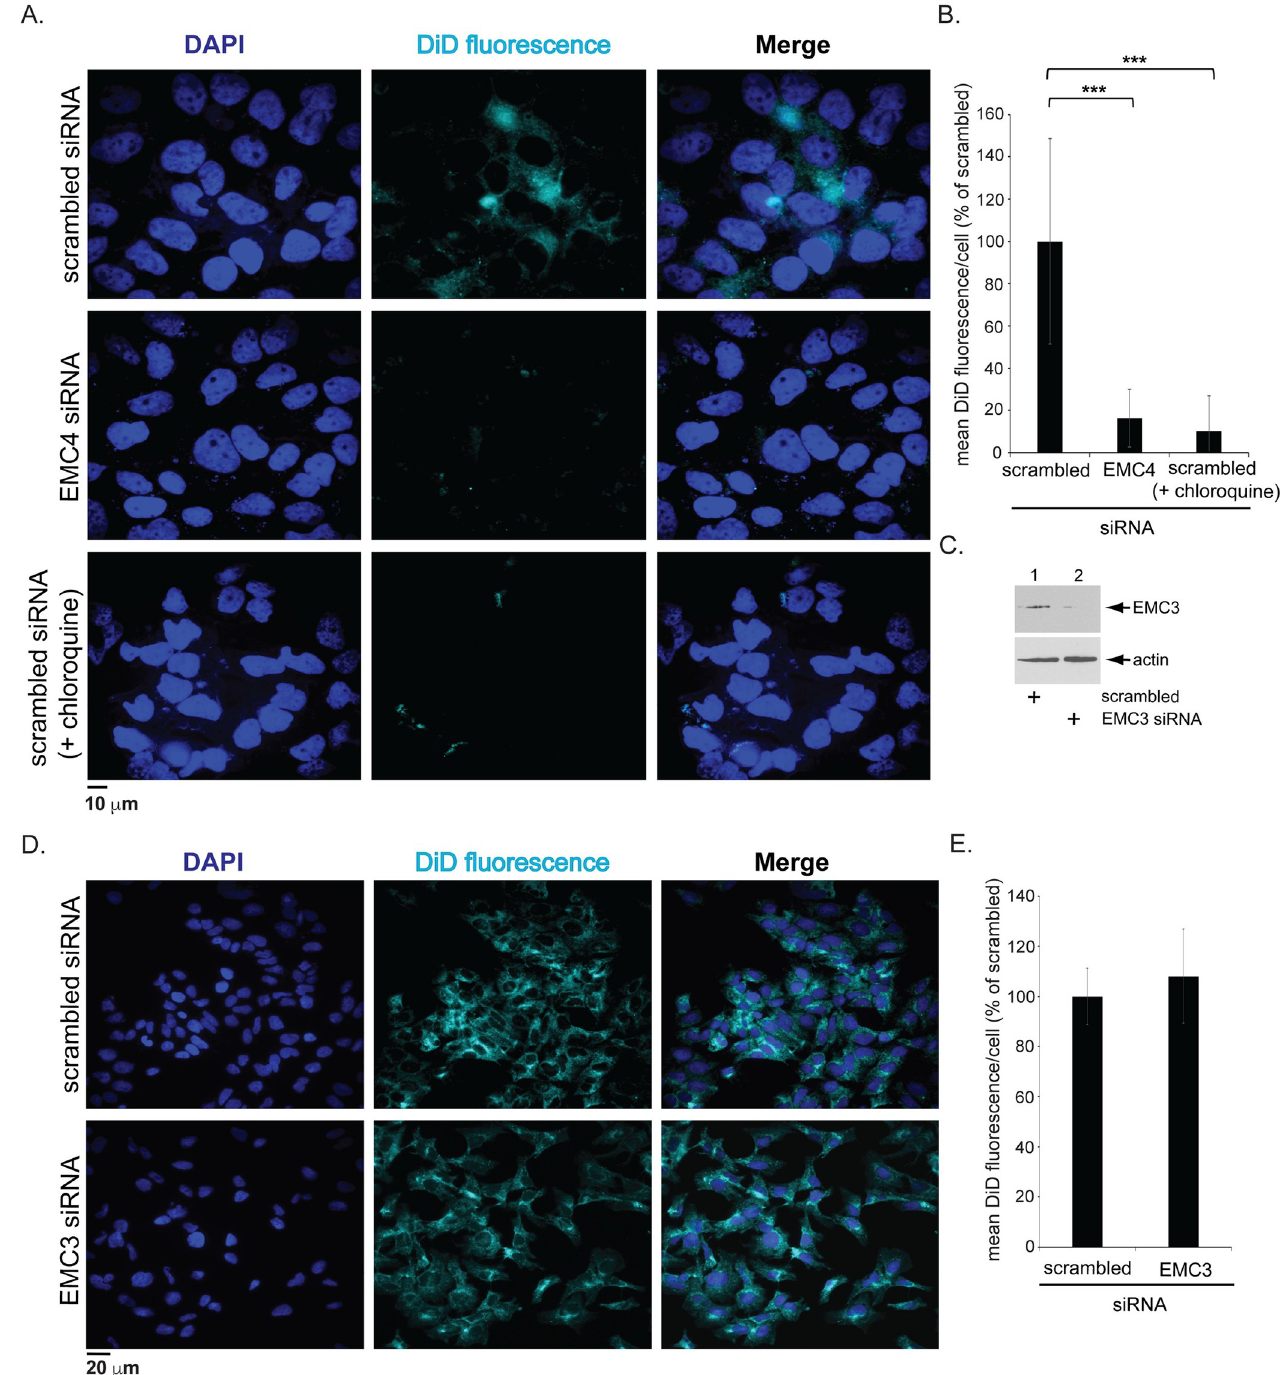
Fig 4. DENV membrane fusion is dependent on EMC4. A. Huh 7.5.1 cells were transfected with the indicated siRNAs followed by infection with DiD-labeled luc-DENV2 for 1 h (MOI 5) with or without chloroquine, fixed, and imaged under widefield epifluorescence microscope to determine the DiD and DAPI signals. B. Quantification of the mean DiD fluorescence/cell in A (normalized to scrambled). The data values represent the means and standard deviations (SD) ( n � 3). C. Extracts from Huh 7.5.1 cells transfected with the indicated siRNAs were subjected to SDS-PAGE followed by immunoblotting with the indicated antibodies. D. As in A, except EMC3 KD cells were used. E . As in B, except EMC3 KD cells were used for the quantification. ��� P � 0.001.